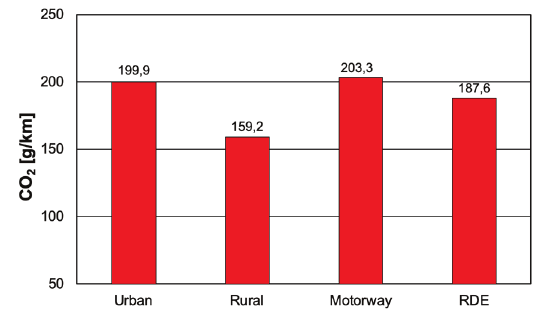
Fig. 9. Emissions of CO 2 in respective phases of RDE cycle and average CO 2 emission in this cycle